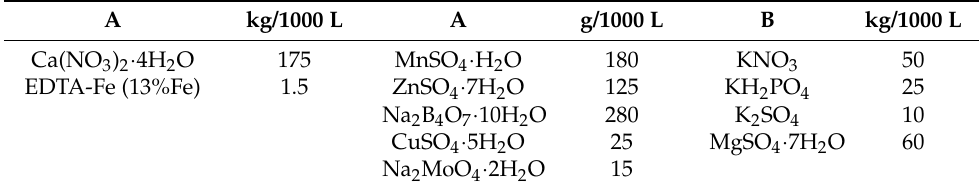
Table 1. Component elements in the mother nutrient solutions A and B in different